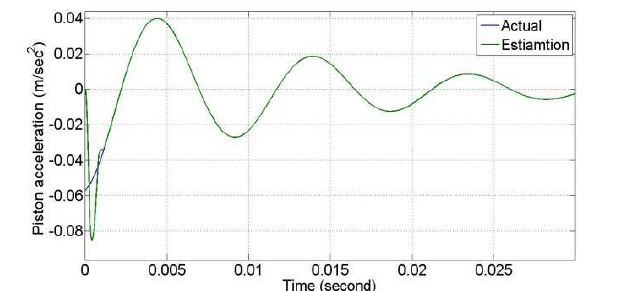
Fig. 4. Open loop piston